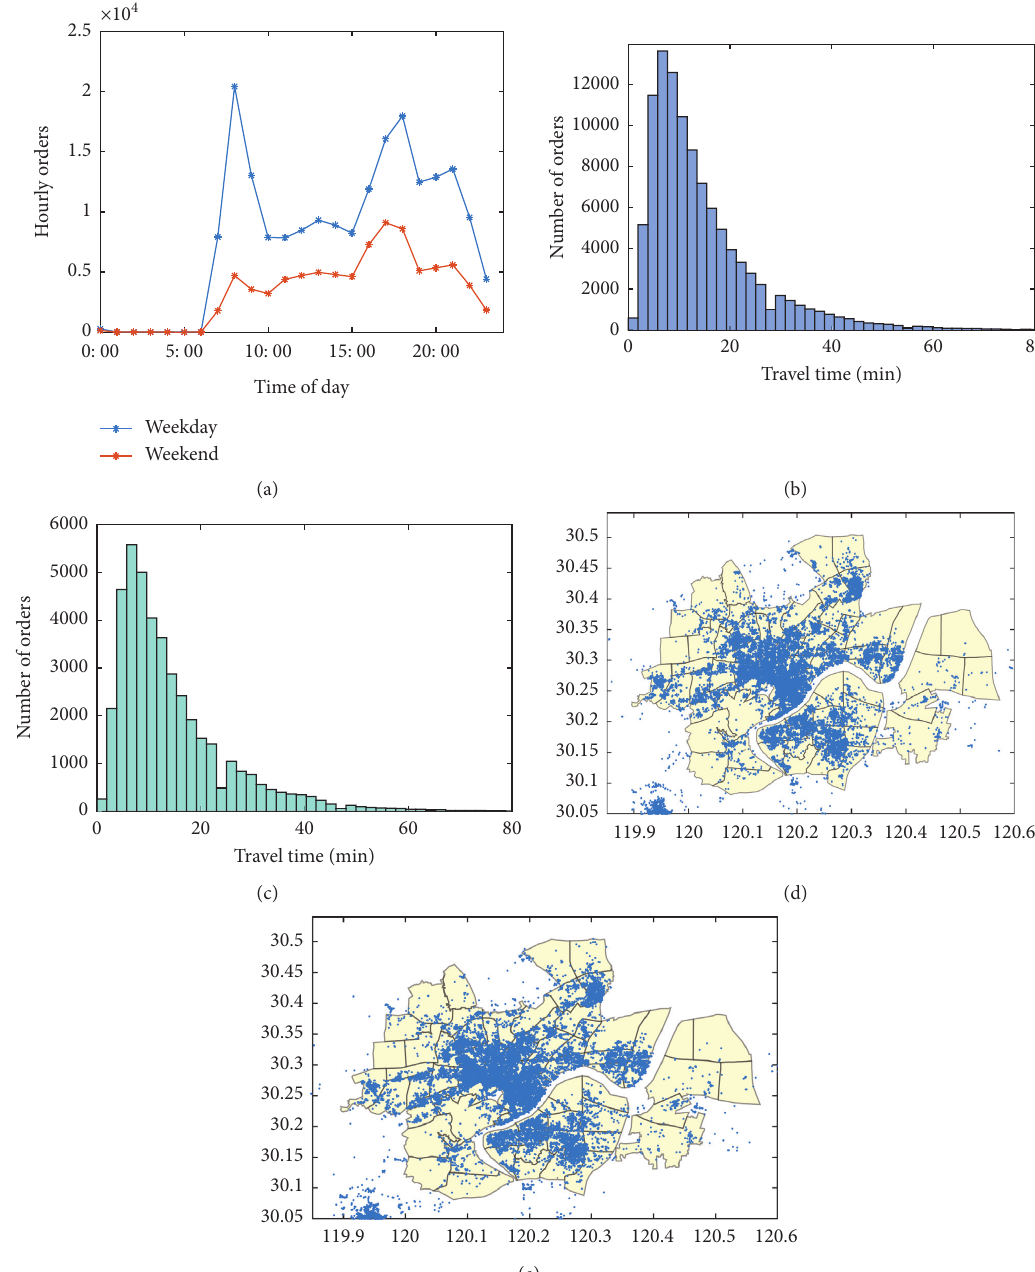
Figure 1: Temporal and spatial distributions of ride-sourcing trips. (a) Ride-sourcing flow. (b) Weekdays. (c) Weekends. (d) Origin distribution in the morning. (e) Origin distribution in the